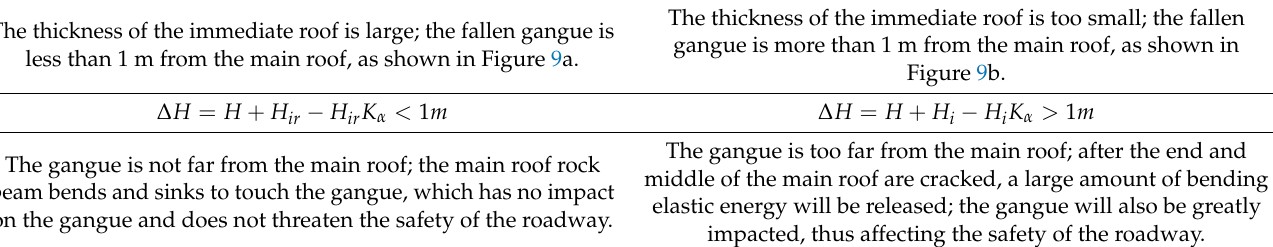
Table 3. Determination of gangue impact [40].